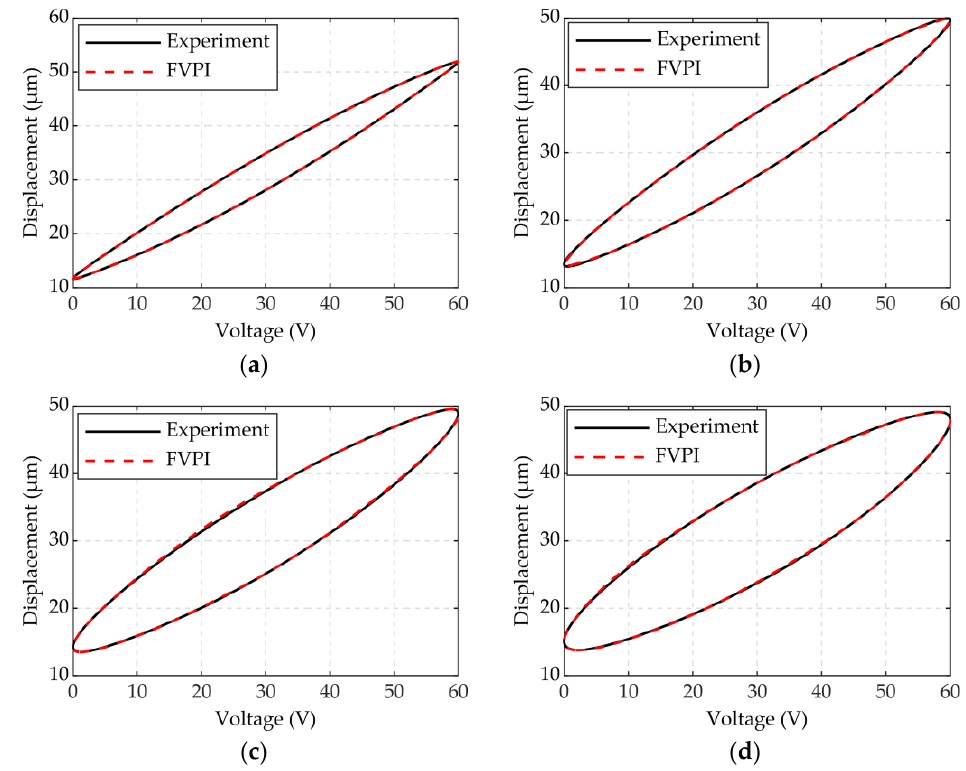
Figure 5. FVPI model with experiment at frequencies: ( a ) 1; ( b ) 100; ( c ) 200; ( d ) 300 Hz.